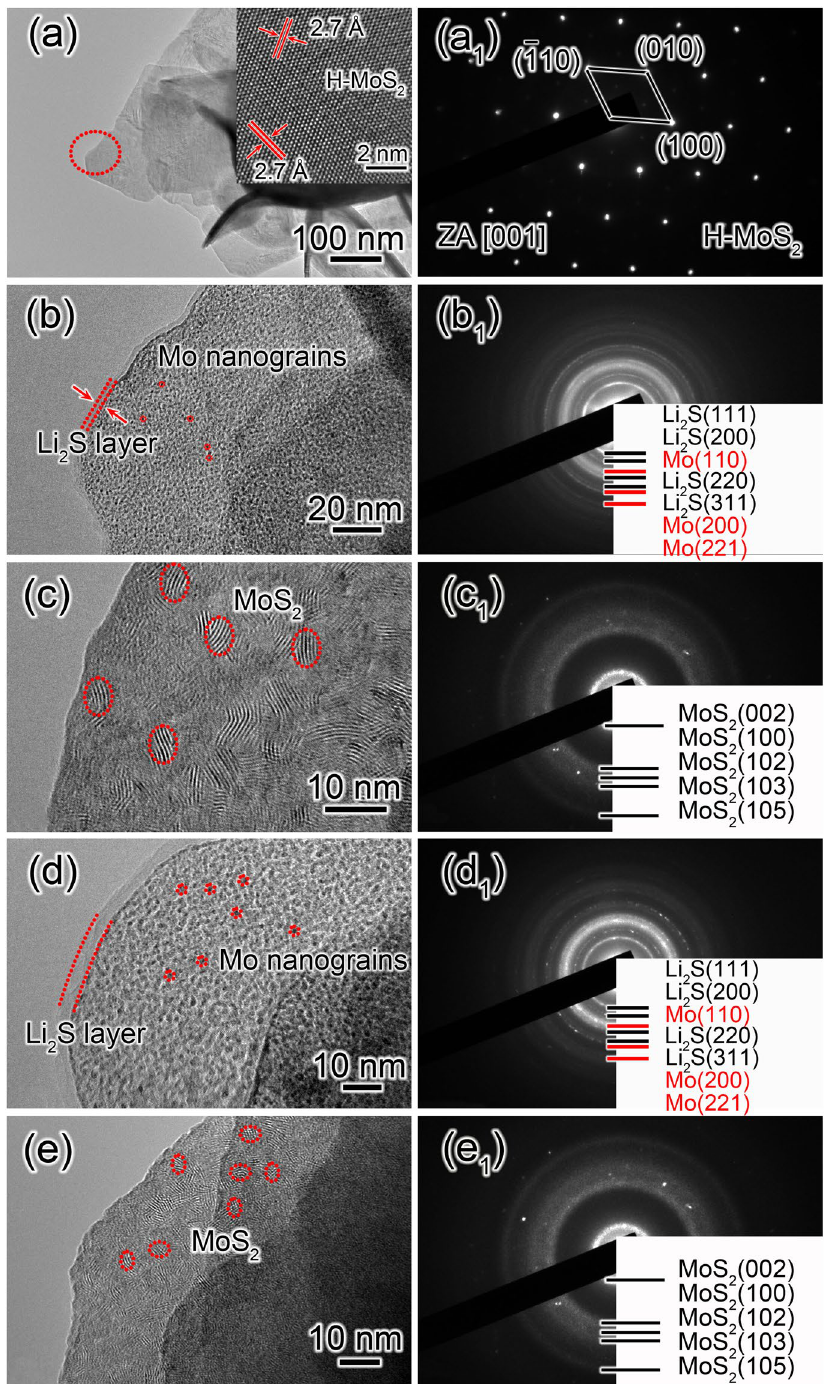
Figure 6. Morphology and structure evolution of MoS 2 electrode during cycling with the potential of − 1.0 V for lithiation and + 3.0 V for delithiation. ( a ) TEM image of the pristine MoS 2 nanosheet. ( b , c ) TEM images of MoS 2 nanosheet after the first lithiation and delithiation. ( d , e ) TEM images of MoS 2 nanosheet after the second lithiation and delithiation. ( a 1 – e 1 ) The corresponding ED patterns of the MoS 2 electrode in ( a – e